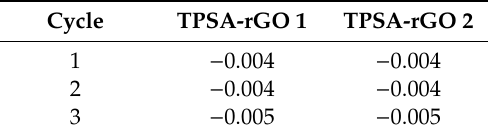
Table 3. Temperature coe ffi cient α (K − 1